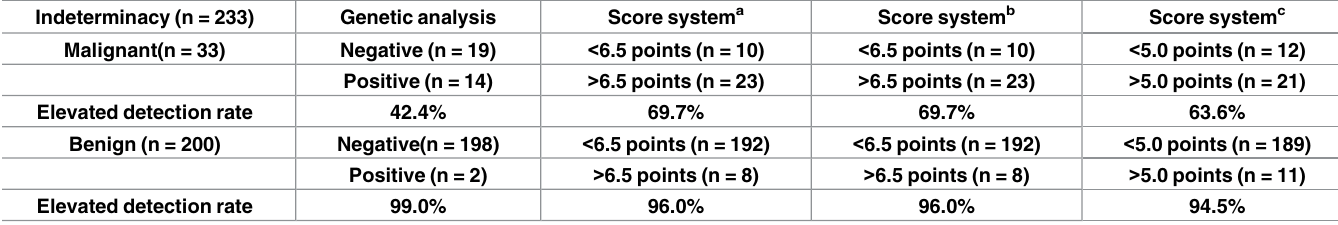
Table 6. The application of three score systemsin 233 uncertain